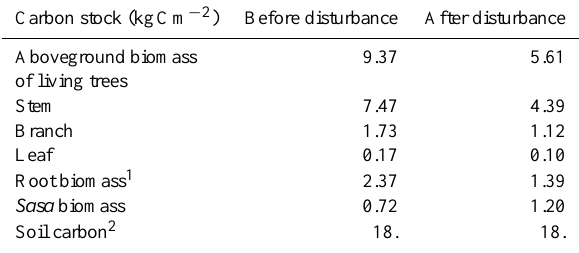
Table 1. Carbon stocks at the SAP site before and after the windthrow disturbance. The periods before and after the disturbance are 2000–2003 and 2006–2008, respectively.